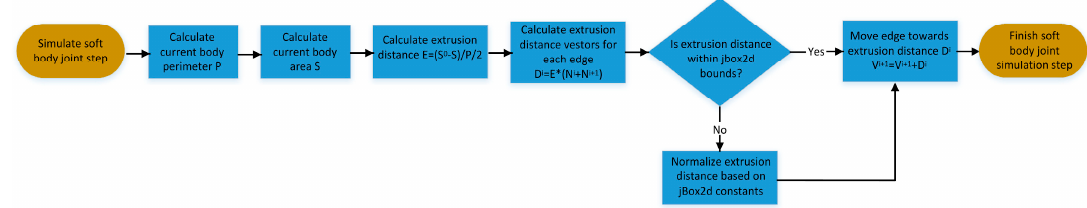
Figure 4. Activity diagram of the game.